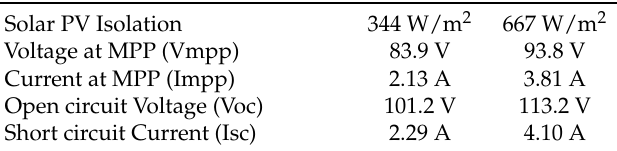
Figure 5. Experiment setup of the MPPT implementation experiment. ( a ) end device setup, ( b ) overall setup. Table 2. Parameters of KC85T solar PV